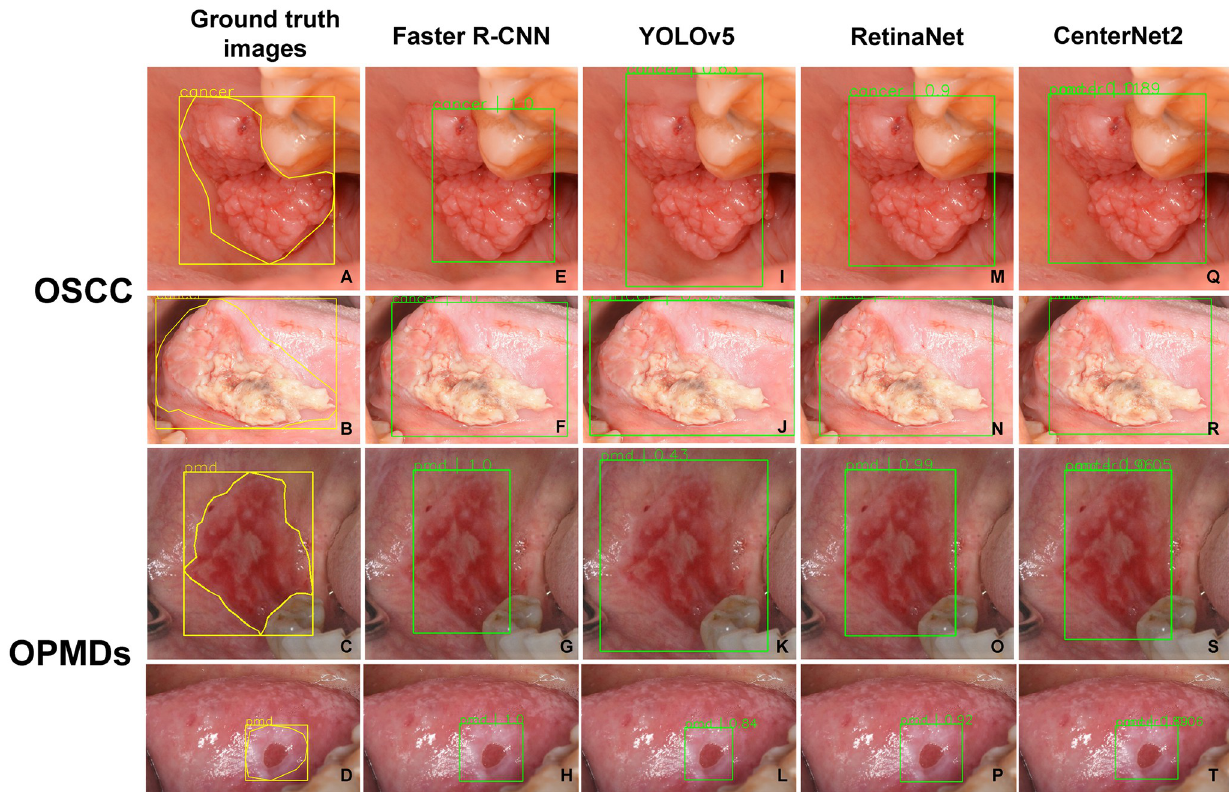
Fig 3. (A-B) Bounding box ground truth based on surgeons’ annotations of the imaging of the patient with OSCC at retromolar trigone and lateral tongue, respectively; (C-D) Bounding box ground truth based on surgeons’ annotations of the imaging of the patient with OPMDs at retromolar trigone and lateral tongue, respectively; (E-H) The true positive outputs from the faster R-CNN detection; (I-L) The true positive outputs from the YOLOv5 detection; (M-P) The true positive outputs from the RetinaNet detection; (Q-T) The true positive outputs from the CenterNet2